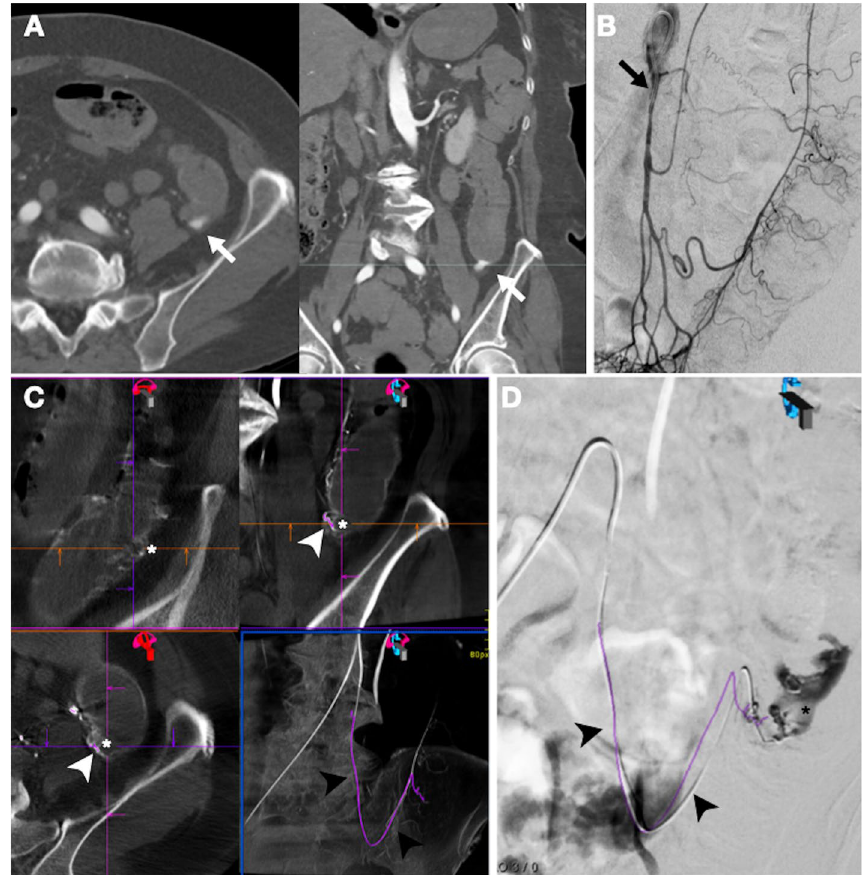
Fig. 1 Empiric TAE approach in patient 1 A Pre-procedural arterial-phase CTA MPR images demonstrates an extravasation in sigmoid diverticula (white arrow). B No extravasation on subsequent DSA with contrast injection in the inferior mesenteric artery (black arrow). C Volumetric inferior mesenteric CBCT dataset displayed as MPR images in the 4D workplace. Although again no bleeding could be demonstrated, this allowed to identify the culprit diverticula (white asterisk) based on prior CTA. Then, the adjacent vas rectum (white arrowhead), presumably responsible for diverticular arterial supply and LGIB, was pointed as target for vessel detection. After also designating the catheter tip as proximal starting point, the vessel trajectory to the defined target could be identified semi-automatically (black arrowhead). D 3D roadmap (black arrowhead) virtually displayed on fluoroscopy for real-time guidance. After engaging the targeted vas rectum with a microcatheter, super-selective contrast injection ultimately reveals an extravasation (black